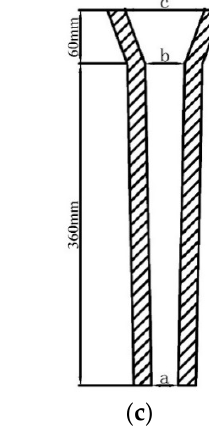
Figure 3. ( a ) Sketch of physical model; ( b ) photo of physical model; and ( c ) sketch of submerged refractory funnel.